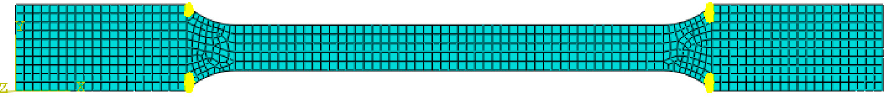
Figure 13. Mesh generated on the model of tested samples.